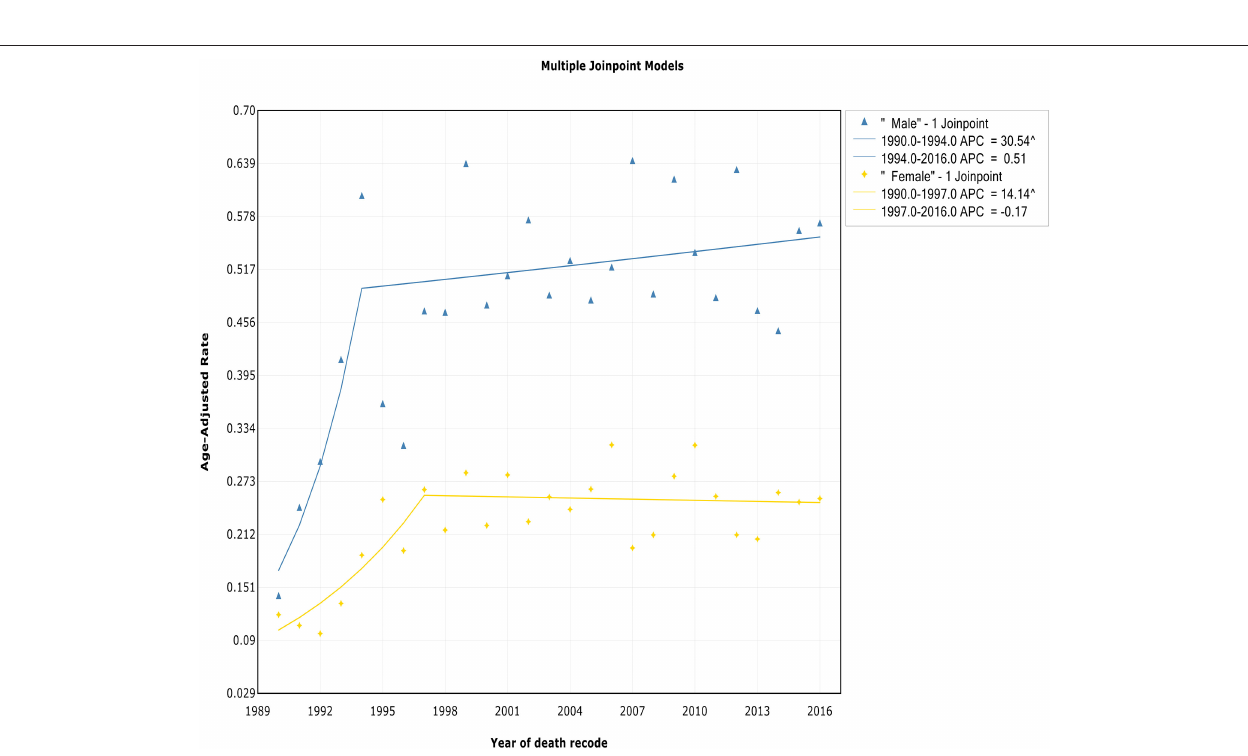
FIGURE 4 | Trends in the annual incidence-based mortality of Waldenström macroglobulinemia in patients stratified according to sex.